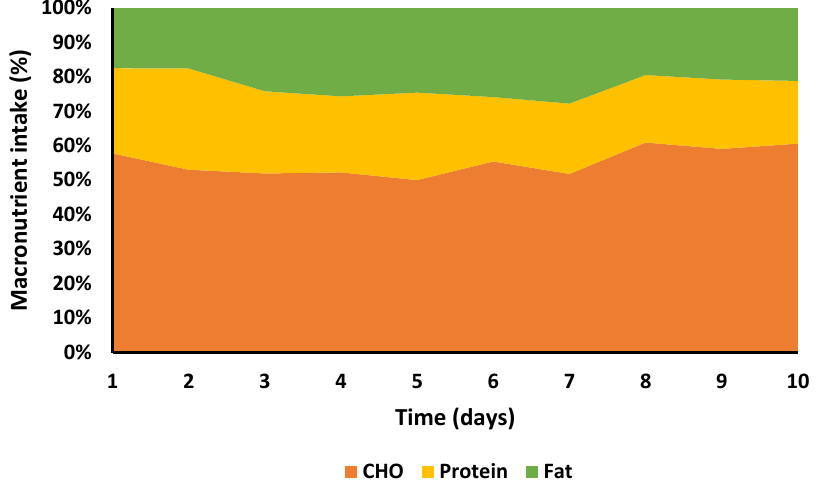
Figure 3. Total macronutrient intake in grams. Series lines link individual data points for the intake of each macronutrient (g) per day. Dashed lines represent the mean intake for each macronutrient across all 10 days.